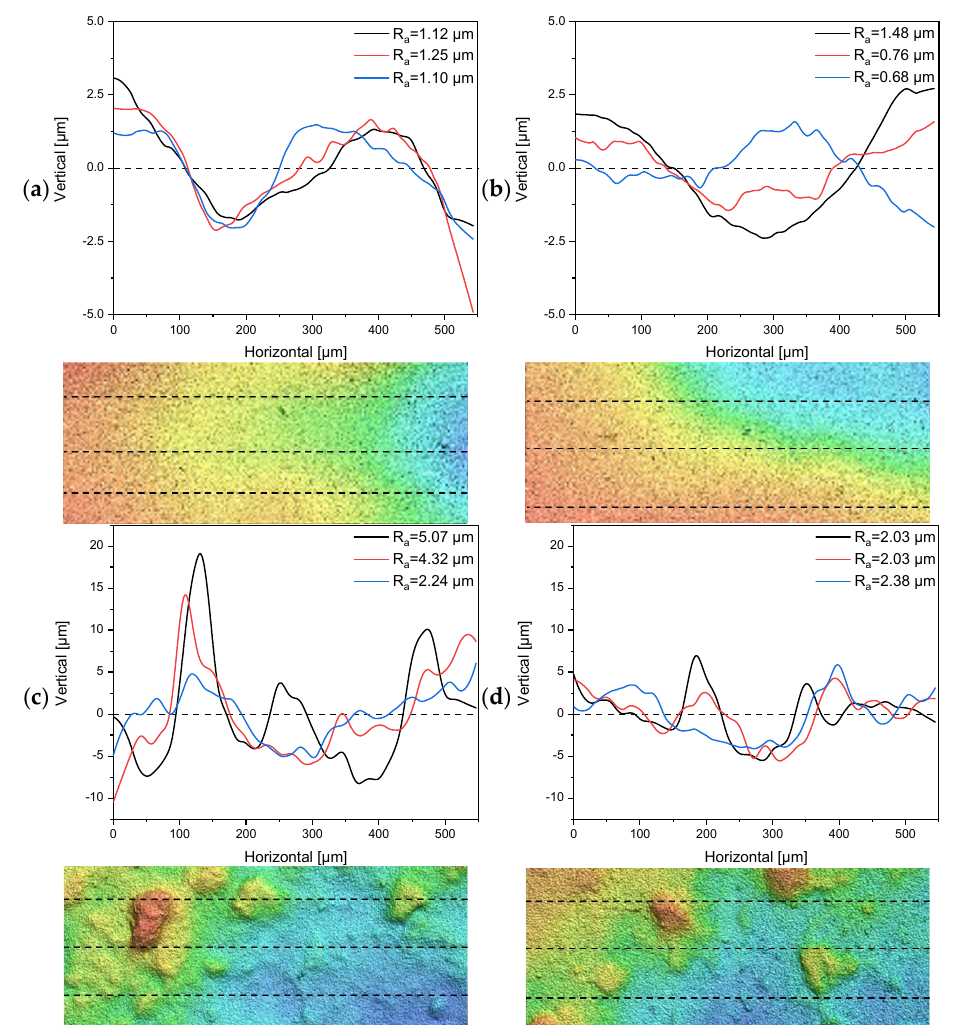
Figure 4. One-dimensional profiles for the determination of surface roughness and topographical images (200 µm × 550 µm) from multiple line measurements of the tubular UF membranes 7C_s and 7C_r. Dashed lines indicate the profile location. ( a , b ) Profiles and topographical images from two randomly-selected segments of membrane 7C_s. ( c , d ) Profiles and topographical images from two randomly-selected segments of membrane 7C_r.